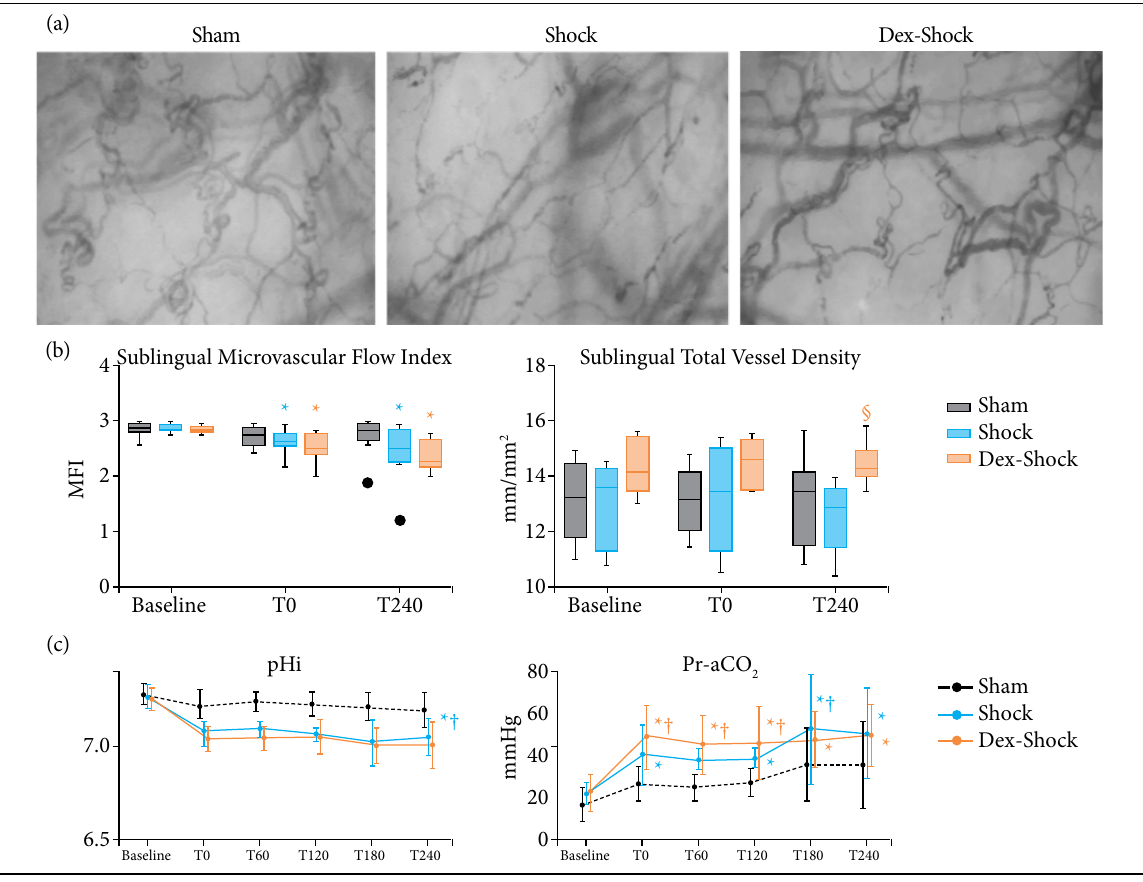
Figure 4 - Sublingual microcirculation and jejunal tonometry in anesthetized pigs (Sham group), septic shock animals (Shock group), and septic shock animals administered a dexmedetomidine infusion (Dex-Shock group). (a) An illustrative example for sublingual vessels density. (b) The median and 25-75 percentile values for sublingual blood flow and vessel density before bacterial infusion, at the end of bacterial infusion (T0), and 240 minutes (T240) after bacterial infusion. (c) The mean values for intestinal pH (pHi) and intestinal mucosal-to-arterial carbon dioxide pressure difference (Pr-aCO